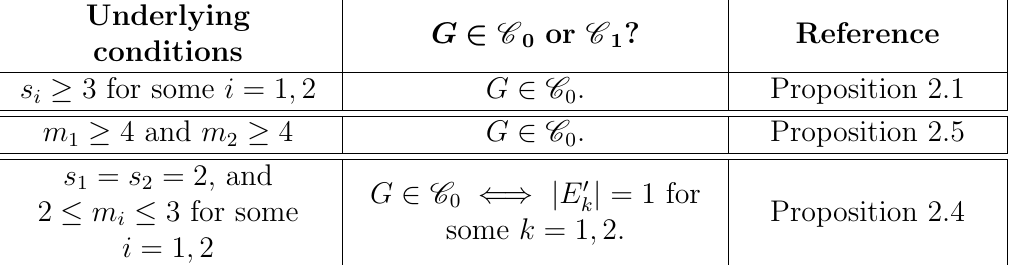
Table 1: Summary for T ( s Underlying conditions